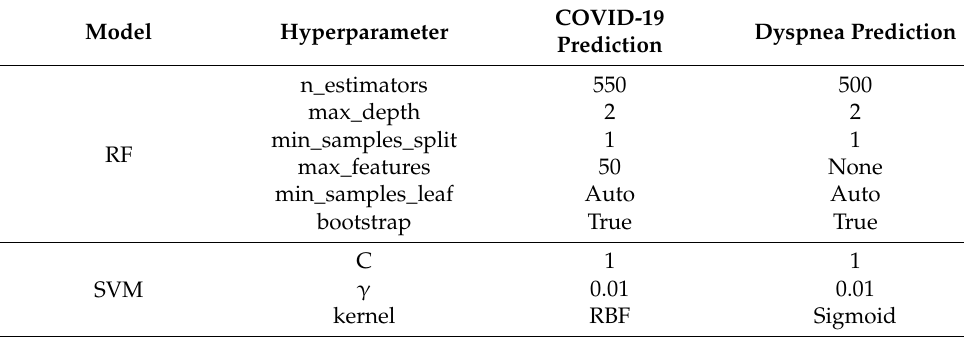
Table 2. RF and SVM hyperparameters for each classification task. Model Hyperparameter